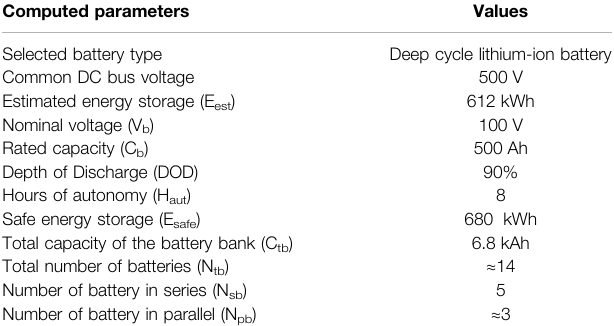
TABLE 2 | Computed battery parameters. Computed parameters